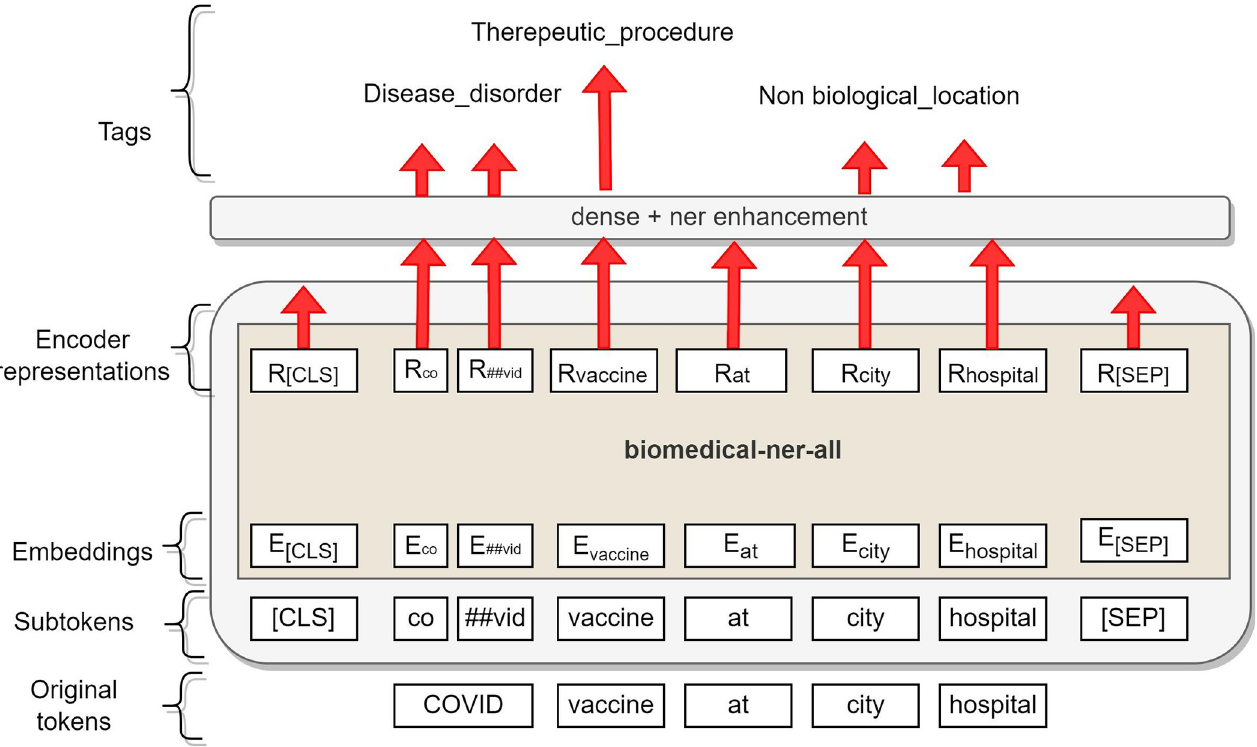
Fig 5. biomedical-ner-all model.